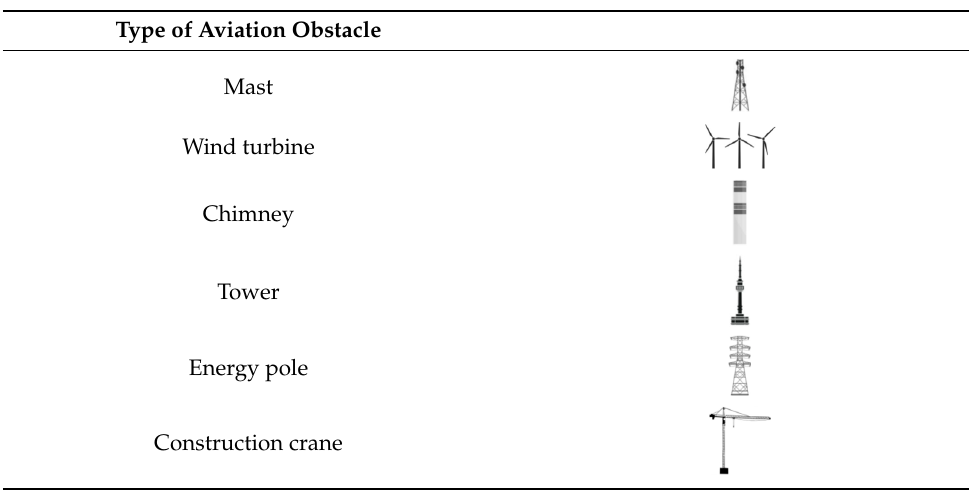
Table 1. Atypical aviation Table 1. Atypical aviation obstacles. Table 1. Atypical aviation obstacles. Table 1. Atypical aviation obstacles. Table 1. Atypical aviation obstacles. Table 1. Atypical aviation obstacles. Table 1. Atypical aviation obstacles.